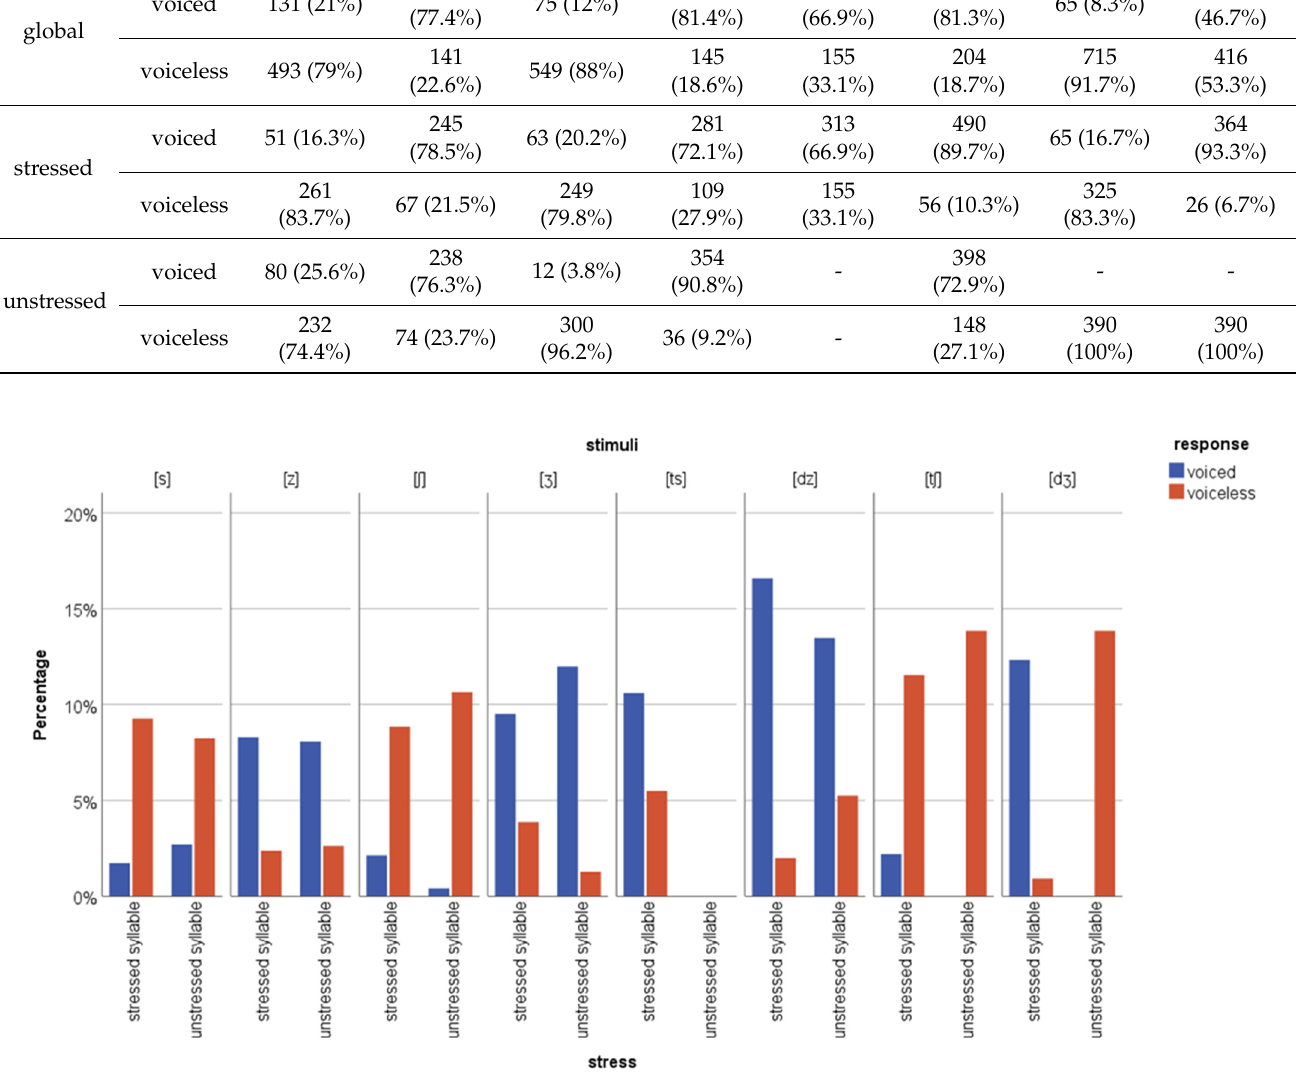
Figure 3. Bar plots representing the portion of voiced and voiceless identifications for each sibilant category depending on stress. category depending on